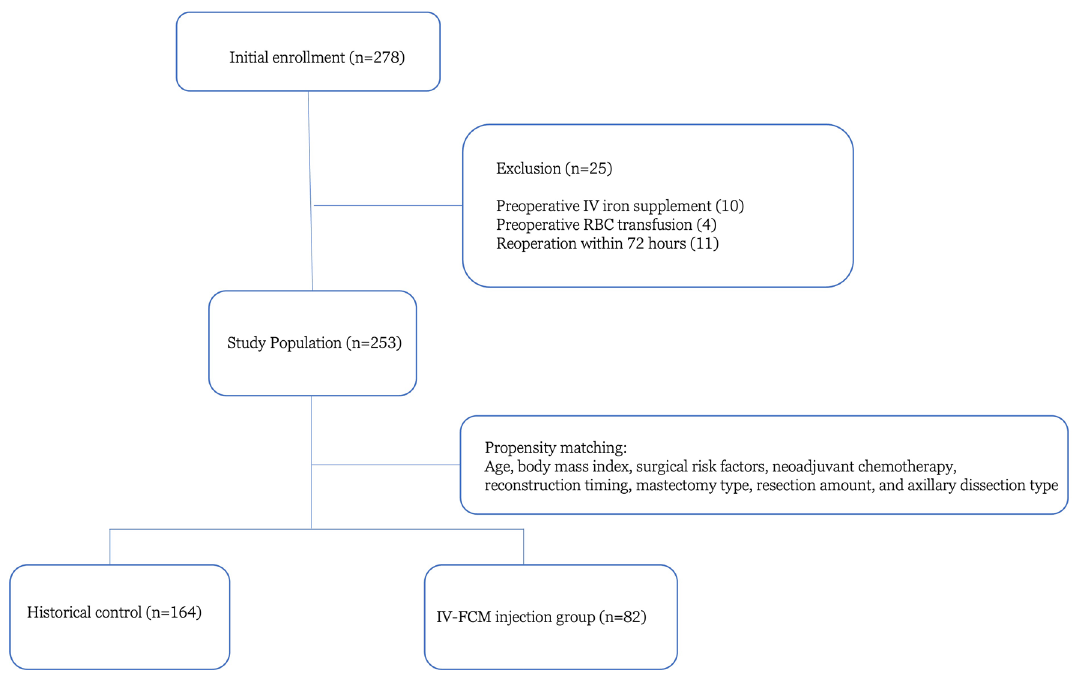
Figure 1. Flowchart illustrating the exclusion and inclusion criteria of the present